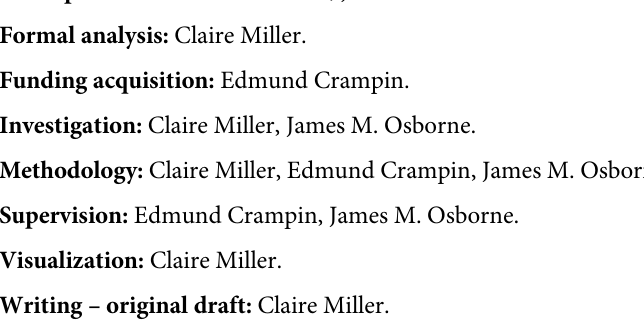
(shown in Fig 5) with no inhibitor present, with cells coloured by (left) the proportion of remaining corneodesmosome, s , and (right) the proportion of free KLK enzyme. S3 Video. Treated tissue video s . A video of one realisation of the treated system (shown in Fig 7) with half the cells recovered to normal inhibitor levels, and the other half with no inhibi- tor. Cells are coloured by (left) the proportion of remaining corneodesmosome, s , and (right) the proportion of free KLK